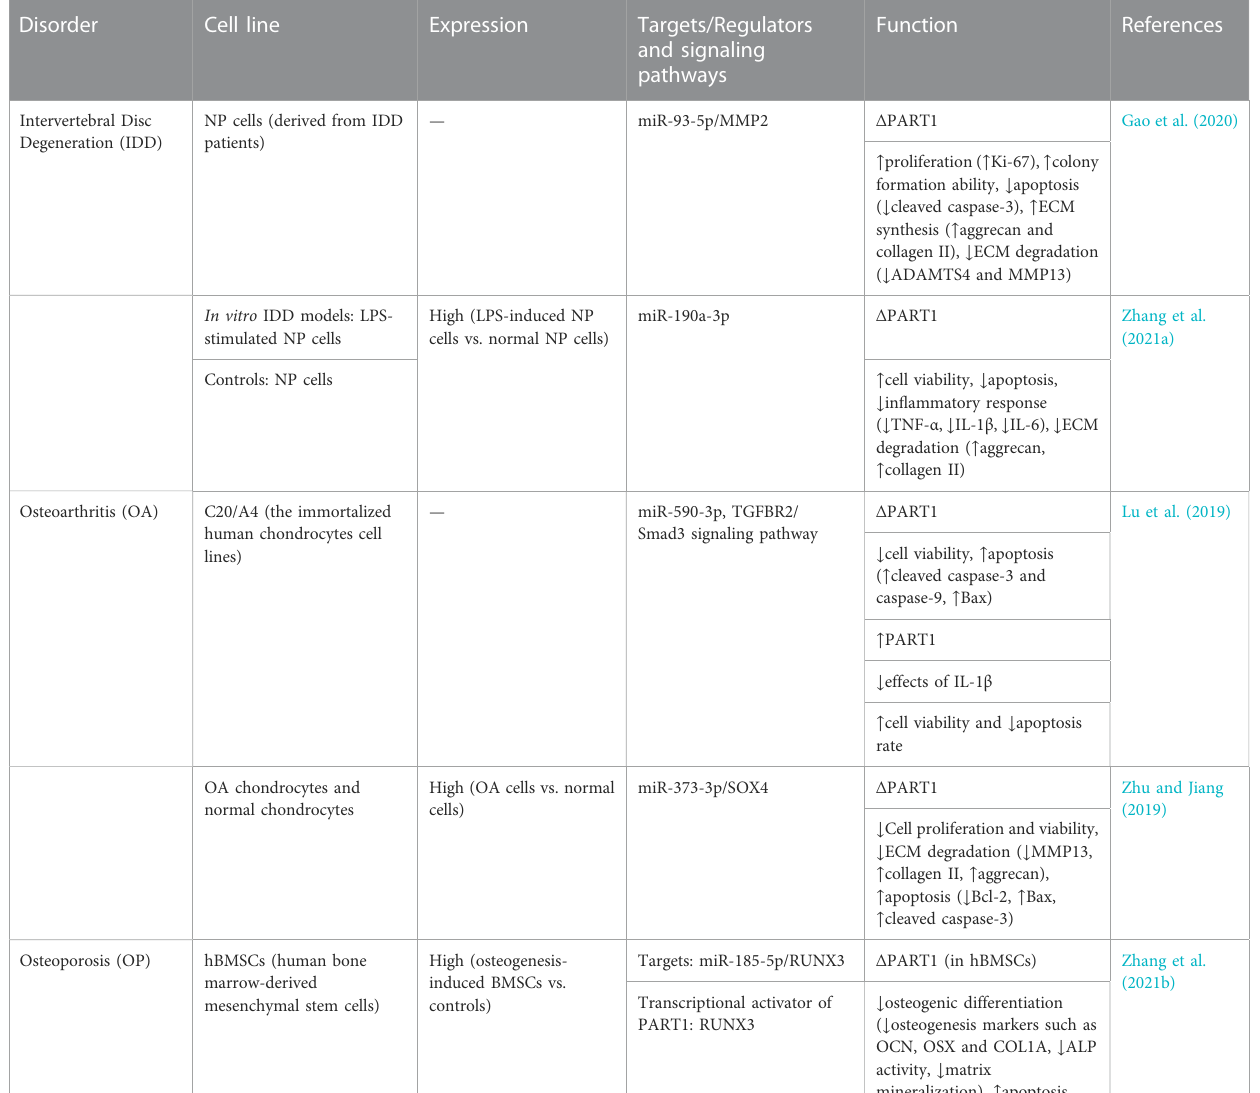
TABLE 7 Cell line studies on PART1 function in non-malignant illnesses in which PART1 has been up-regulated ( Δ : knockdown or deletion, NP cells: nucleus